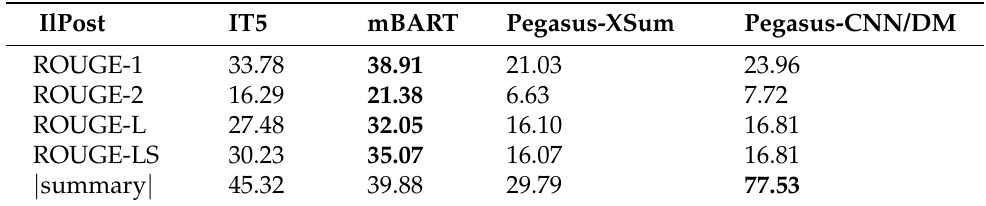
Table 5. Comparison between IT5, mBART, Pegasus-XSum, and Pegasus-CNN/DM, using the same IlPost test set. IT5 and mBART are trained on IlPost, while the two Pegasus models are pre-trained. | Summary | is the length of the summary in terms of the number of words. The best results reported in the table are highlighted in